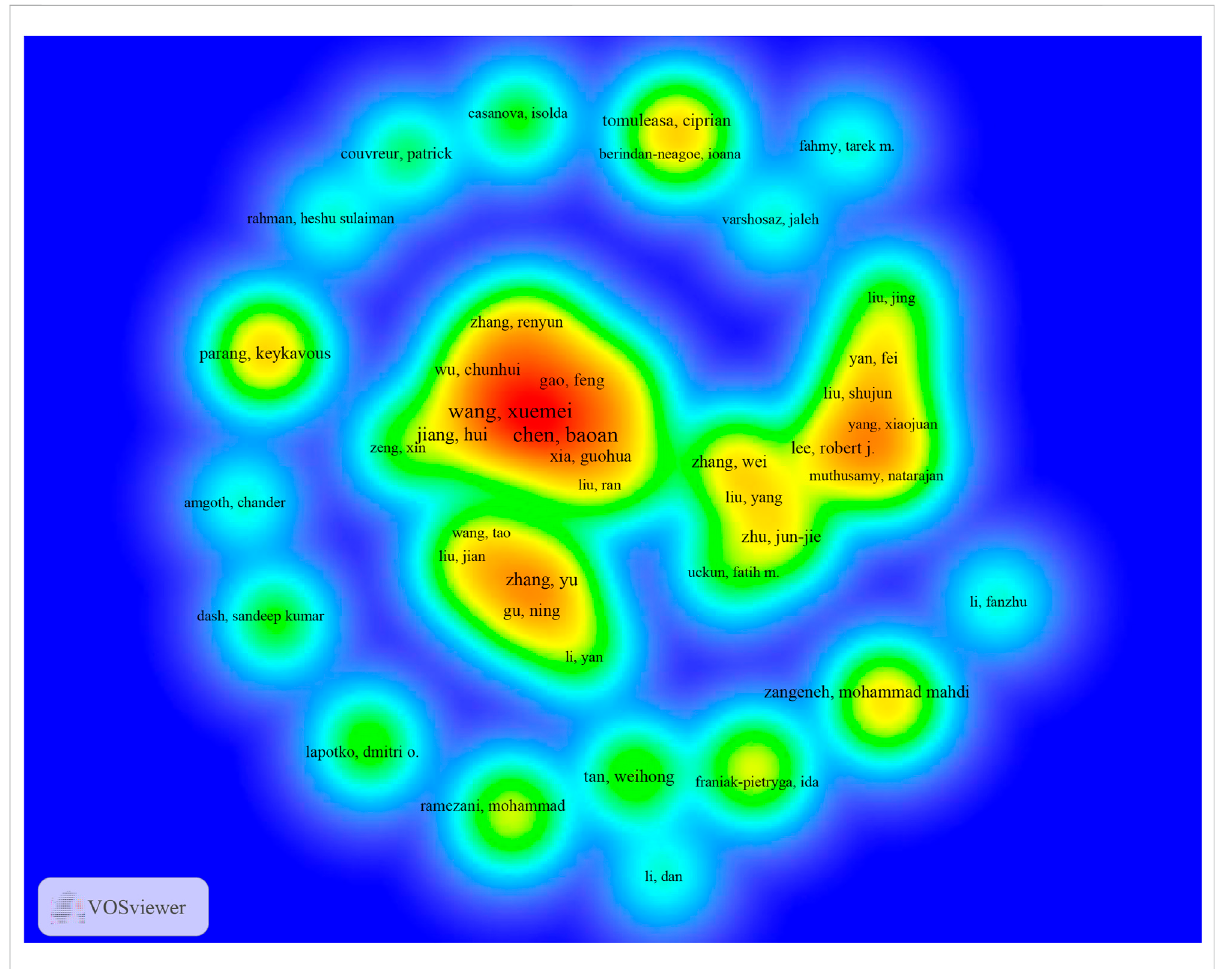
FIGURE 5 The density map of authors in Nanoparticles-leukemia research (T ≥ 5). Notes: The size of the word, round, and the opacity of yellow are positively related to the publication frequency.